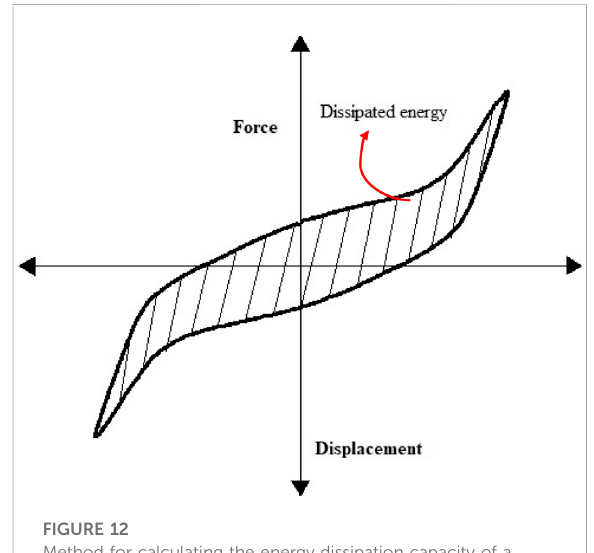
FIGURE 12 Method for calculating the energy dissipation capacity of a hysteresis curve.